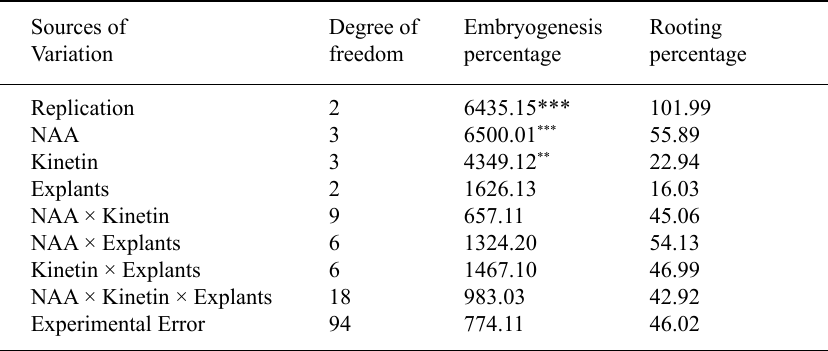
table 2. Analysis of variance for traits assessed in embryogenesis study of different explants of chamomile at different levels of growth regulators 2, 4-D herbicide and Kinetin Degree of Embryogenesis Rooting